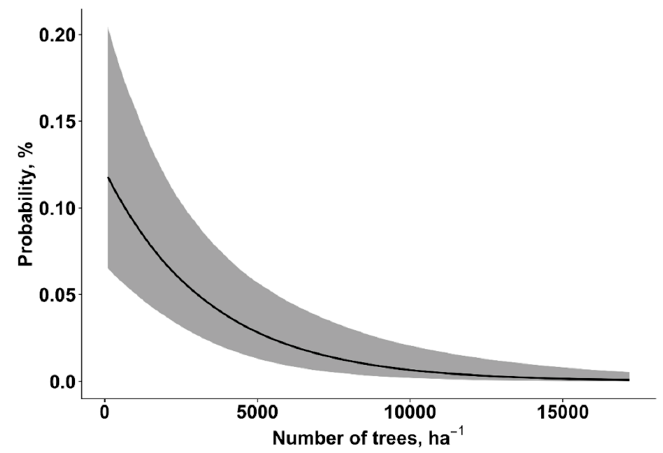
Figure 1. The influence of stand age on the probability of wind damage. The grey area represents the ± 95% credibility interval.